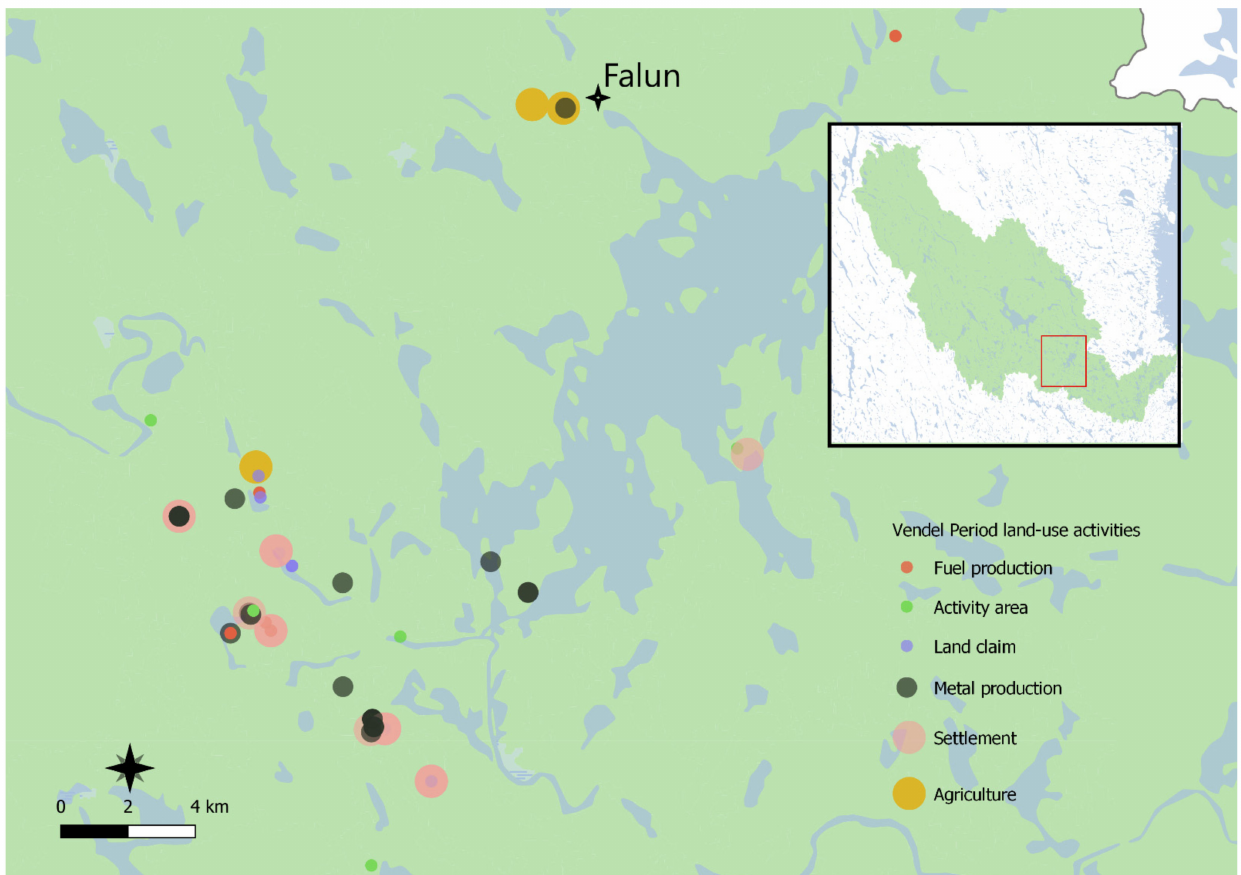
Figure 5. Detail of different land-use activities in the Vendel Period; shoreline level at 600 BCE© SGU; boundaries shapefiles courtesy of European Environmental Agency (EEA); background map courtesy of CORINE landcover 2018